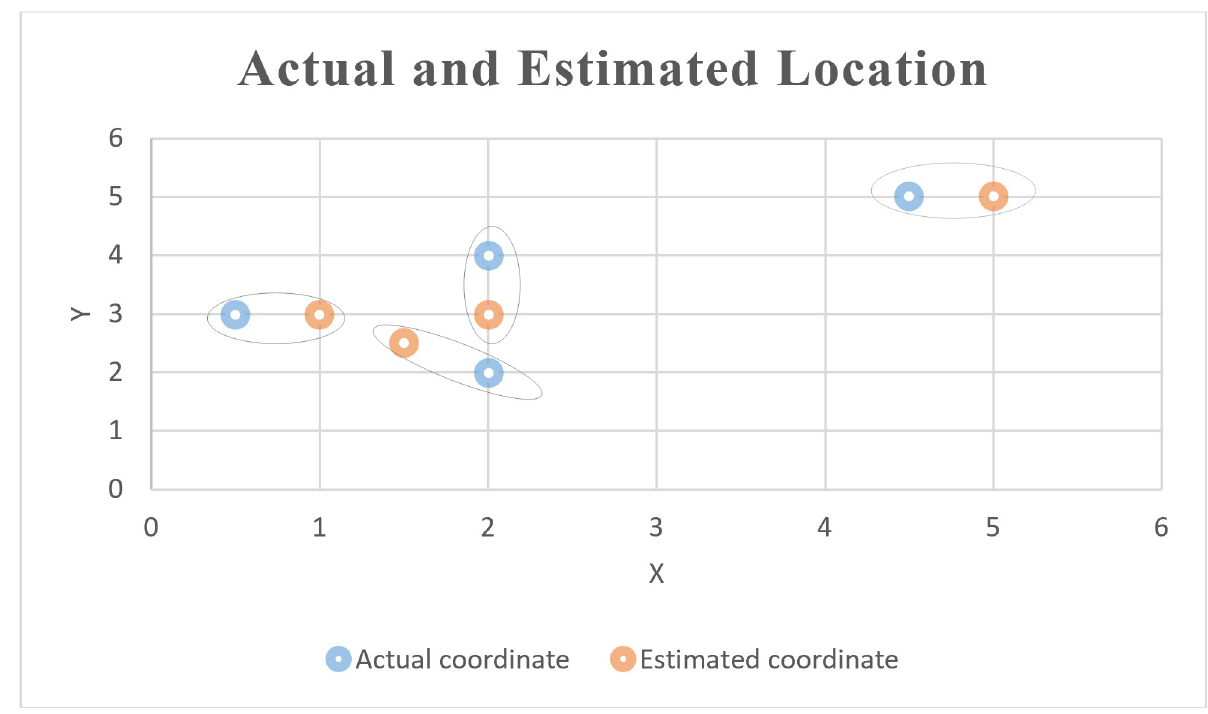
Fig 12. The different between the actual locations and estimated